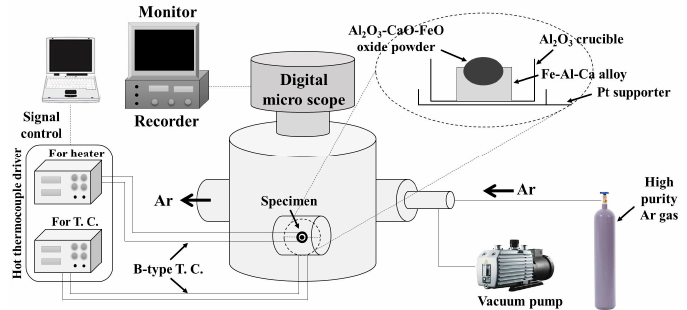
Figure 1. Experimental setup for oxide pre-melting experiment using a confocal scanning laser microscope (CSLM).